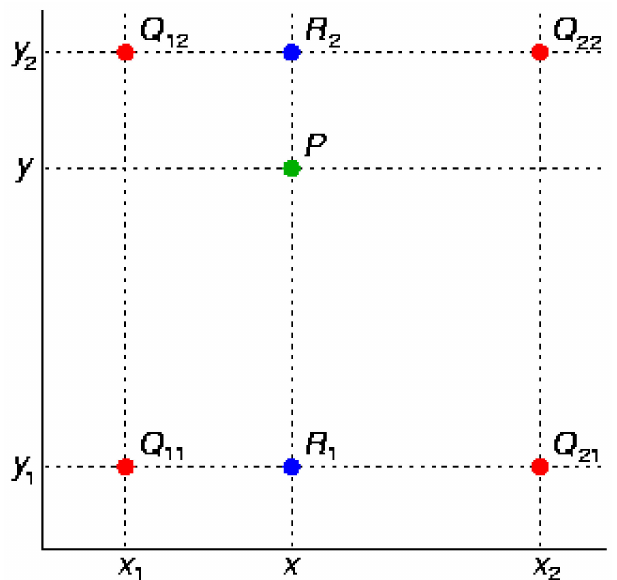
Figure 8. Schematic diagram of bilinear